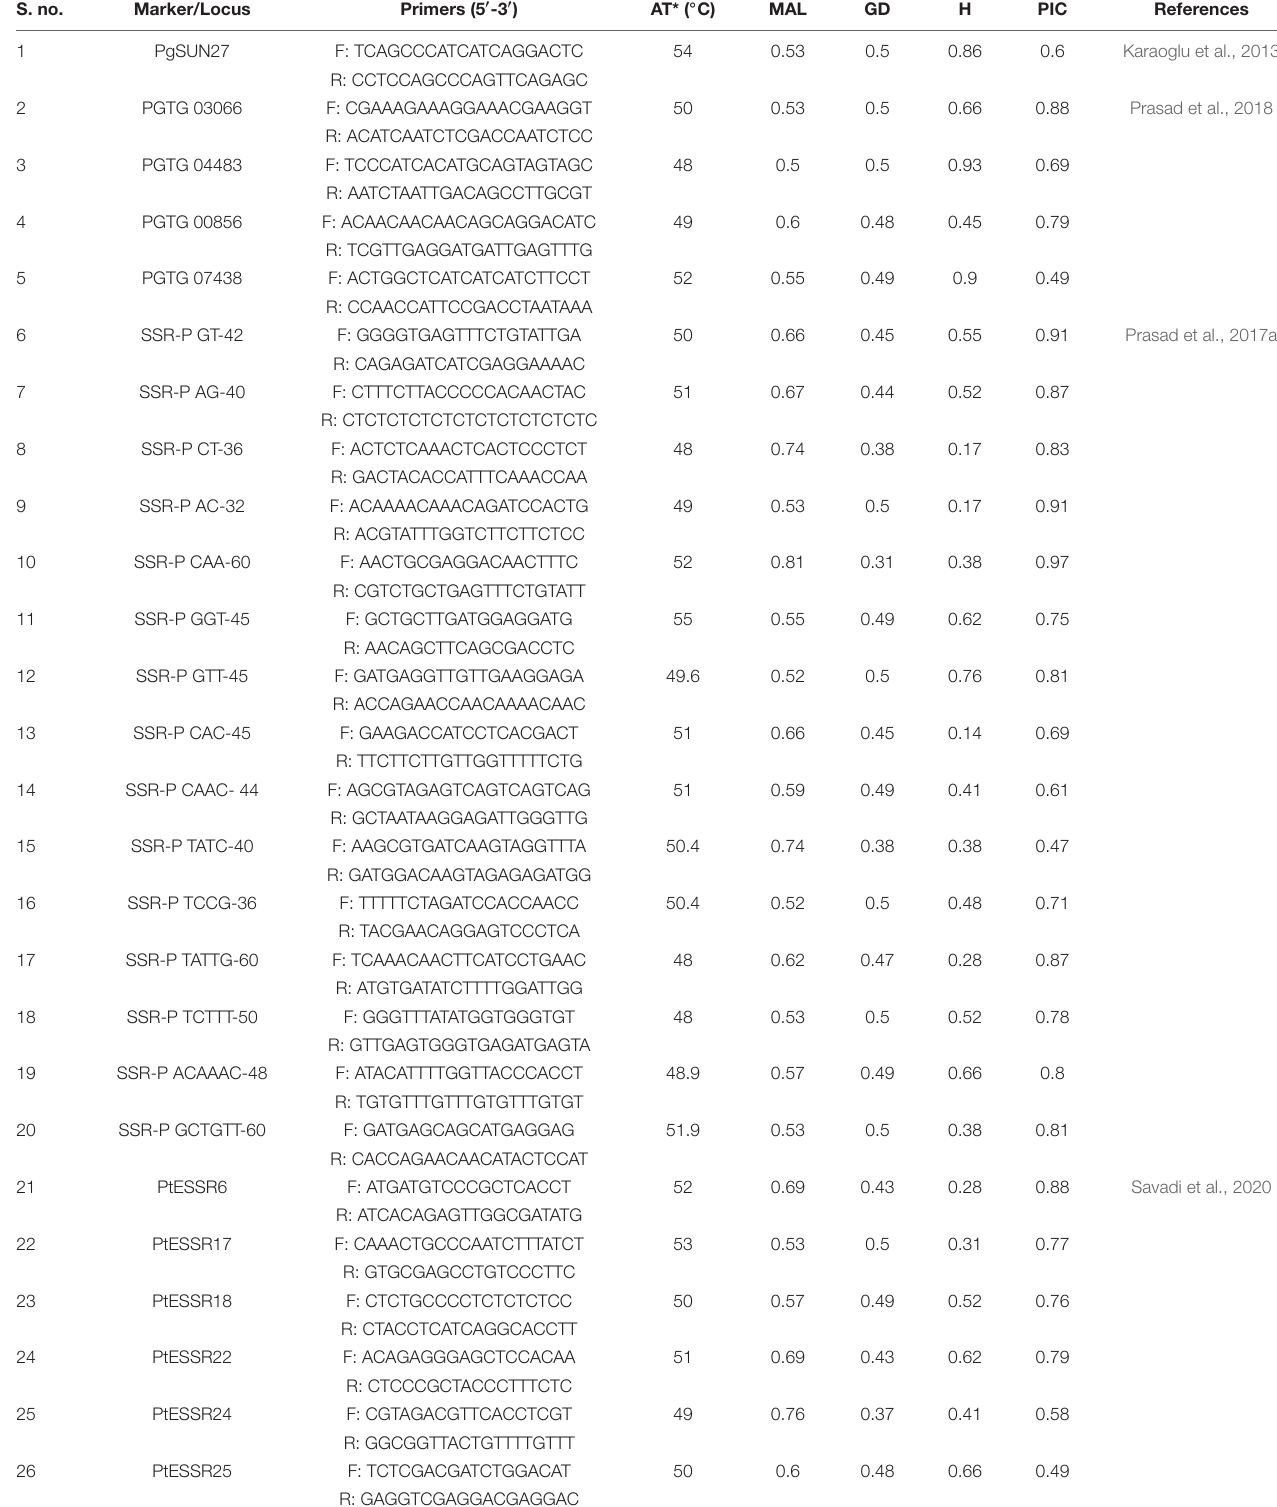
TABLE 2 | List of 37 SSR markers used for population genetic diversity analysis of Puccinia graminis f. sp. tritici and their sequence, annealing temperature, major allele frequency, gene diversity, heterozygosity, and polymorphic information content (PIC) values. S. no.